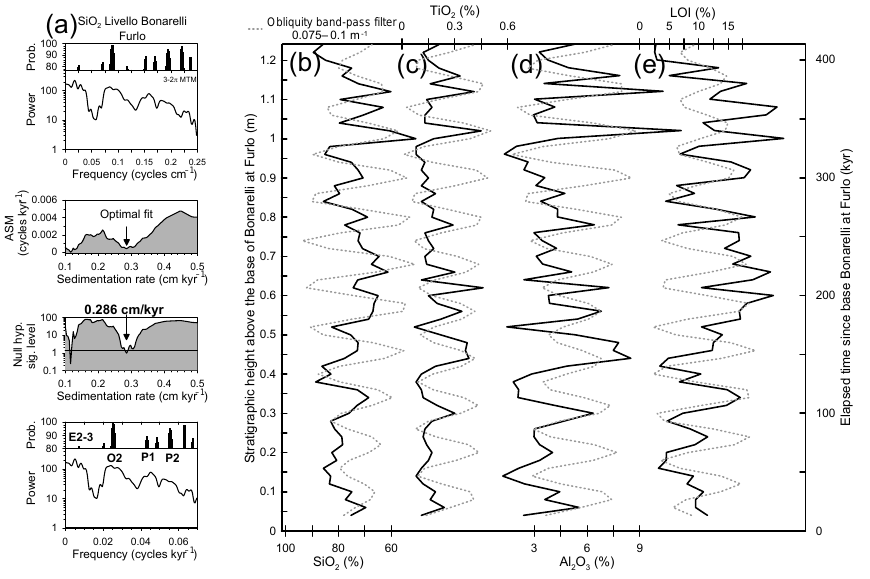
Figure 4. Duration estimate of Livello Bonarelli at Furlo based on (a) the average spectral misfit (ASM) method. (b–e) SiO 2 , TiO 2 , and Al 2 O 3 contents and loss-on-ignition (LOI) data show ∼ 12cm thick cycles, interpreted as obliquity. The duration of Livello Bonarelli at Furlo is estimated at 413kyr.